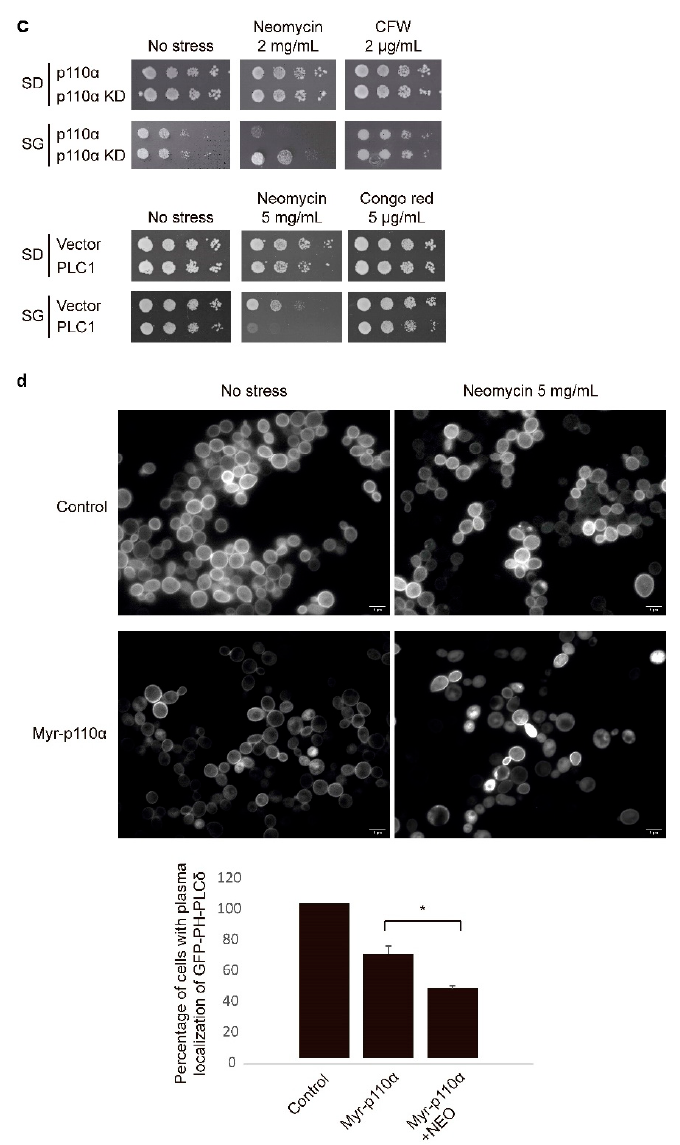
Figure 5. ( a ) Fluorescence microscopy images of the wild-type YPH499 strain co-expressing the PIP 2 marker GFP-2XPH (PLC δ ) and p110 α -KD from the plasmids pJMCS-DM23 and YCpLG-p110 α KD, respectively, treated or not with neomycin 5 mg/mL and cultured in SR-G for 5 h. ( b ). Fluorescence microscopy images of YPH499 strain expressing the phosphatidylserine (PS) marker RFP-LactC2 from the plasmid pRS416- RFP-LactC2 treated or not with neomycin 5 mg/mL cultured in SD for 5 h. ( c ) Growth assays of YPH499 strain transformed with plasmids YcpLG-p110 α or YcpLG-p110 α KD on SD and SG plates containing no stress, 2 mg/mL of neomycin, or 5 µ g/mL of CFW (upper panel). Growth assays of YPH499 cells transformed with plasmids BG1805-PLC1 or pYES2 as control on SD/SG plates containing no stress, 5 mg/mL of neomycin, or 10 µ g/mL of CR (lower panel). A representative assay from three independent experiments is shown. ( d ) Fluorescence microscopy images of the YPH499 strain expressing the PIP 2 marker GFP-2X-PH(PLC δ 1) with either an inactive version of p110 α (control) or Myr-p110 α from plasmids pJMCS-DM23, YcpLG-p110 α KD and YcpLG- Myr-p110 α , respectively, treated or not with 5 mg/mL of neomycin for 5 h and cultured in SR-G. Scale bars correspond to 5 µ m. The graph shows the mean percentage of cells with PM labeling with GFP-2XPH (PLC δ 1) from three independent experiments and error bars indicate the standard deviation. An asterisk indicates statistical significance relative to the control strain according to a Student’s t -test (* = p -value <